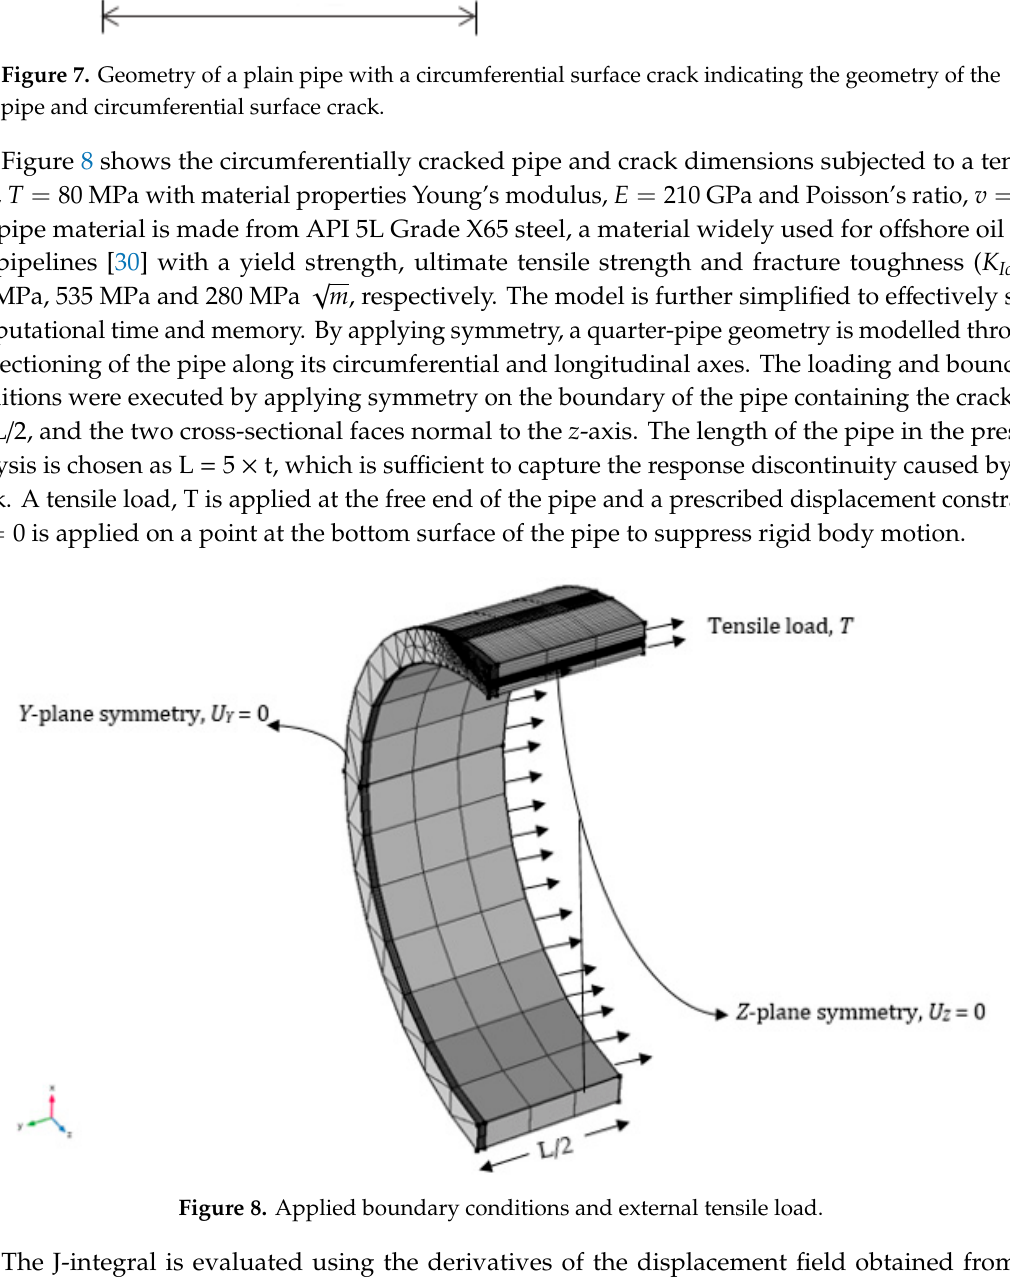
Figure 8. Applied boundary conditions and external tensile load.